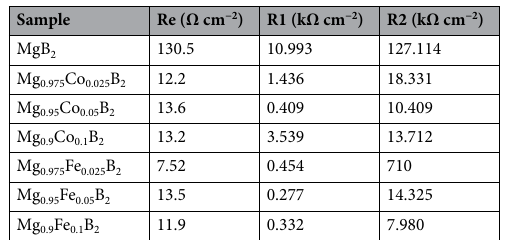
Table 2. Equivalent-circuit element values for EIS data in the 1 M KOH electrolyte.